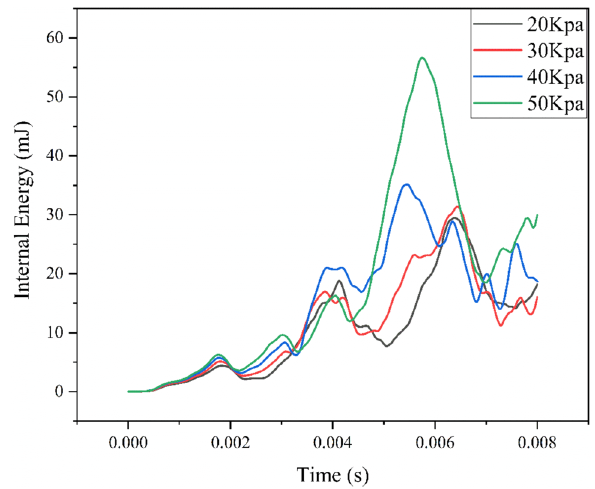
Fig. 13 Energy Saving Lamp internal energy-time change curve